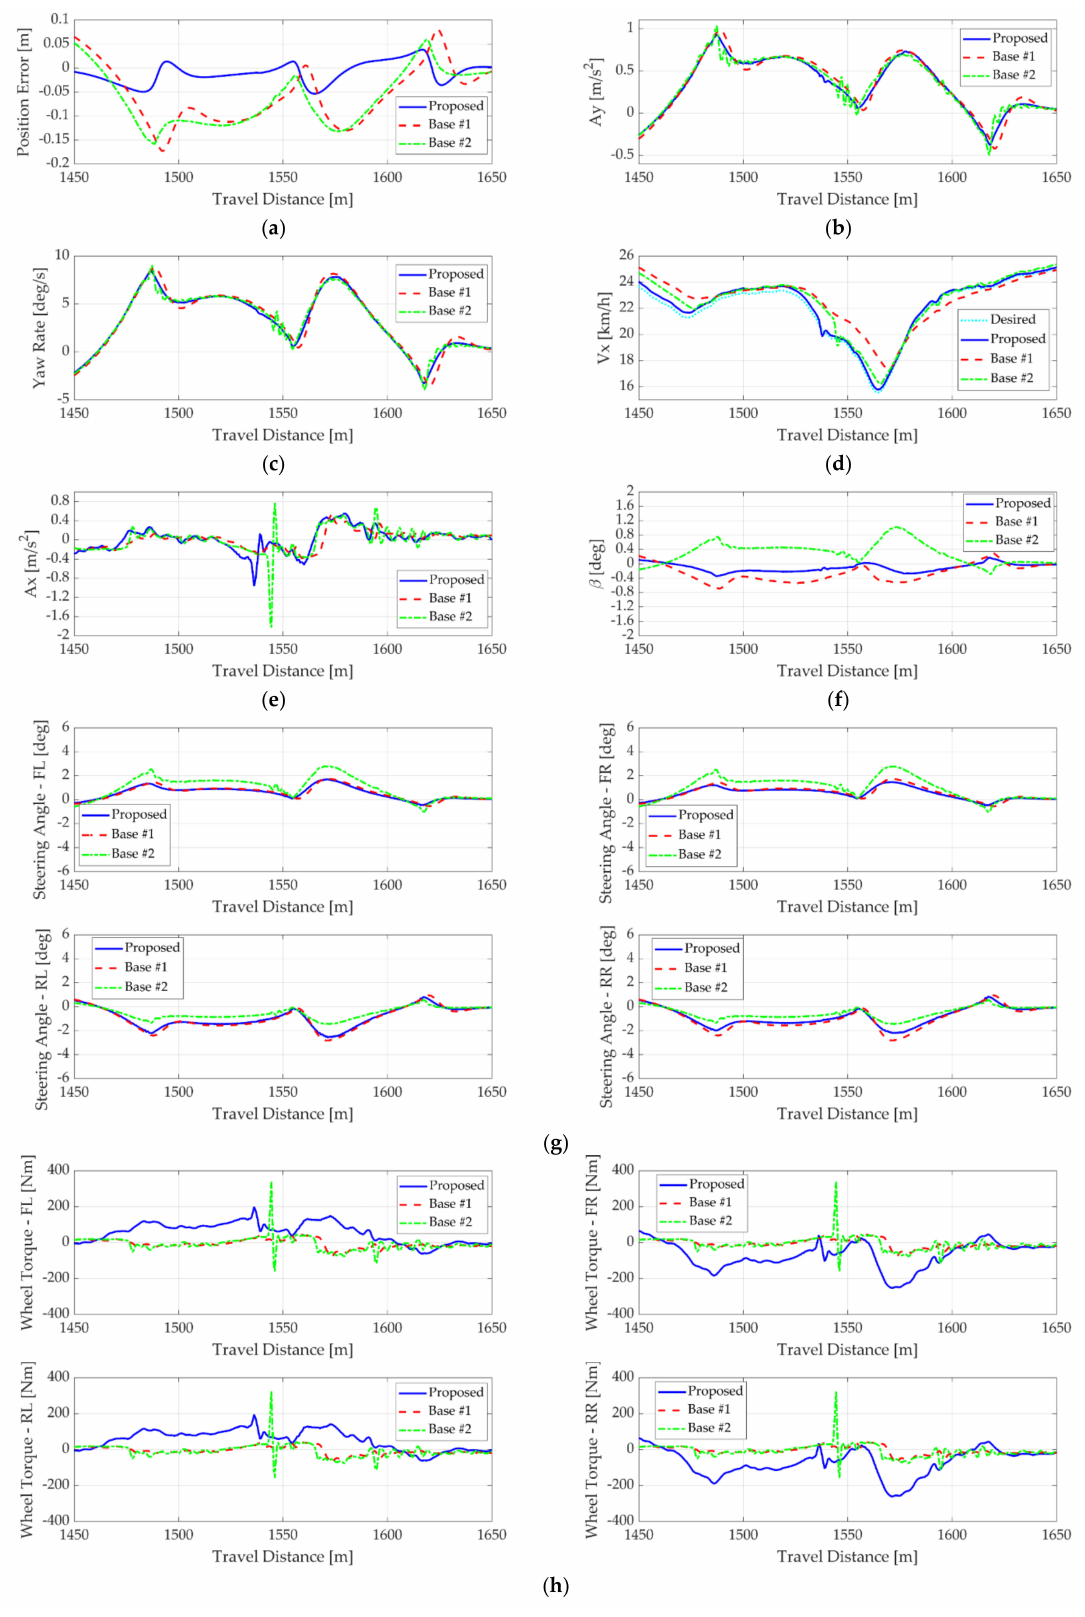
Figure 8. Simulation results of Case #2: ( a ) Position error; ( b ) lateral acceleration; ( c ) yaw rate; ( d ) longitudinal velocity; ( e ) longitudinal acceleration; ( f ) body slip angle; ( g ) steering angle; ( h ) wheel